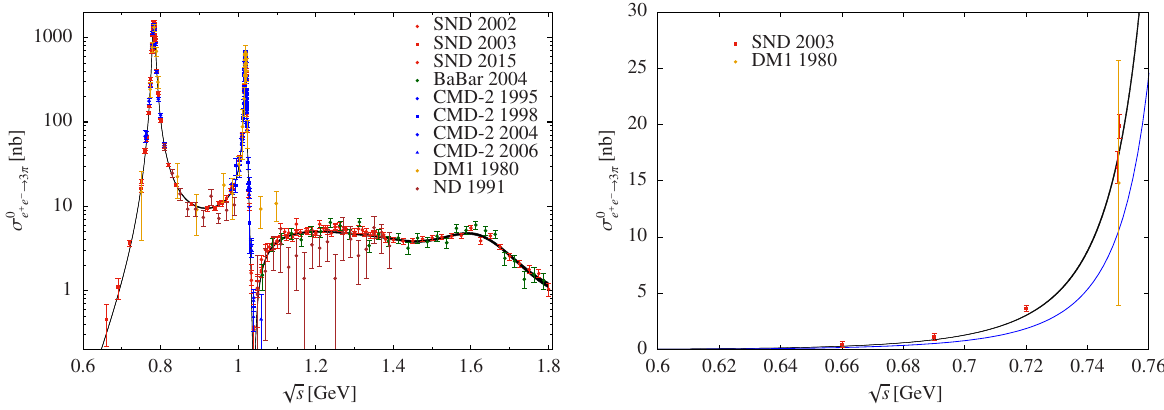
Figure 1. Fit to the bare e + e − 3 π data sets as listed in Table 1 (left) and the comparison to the estimate from [76, 77] (blue curve) in → the near threshold region (right). The black error band represents the fit